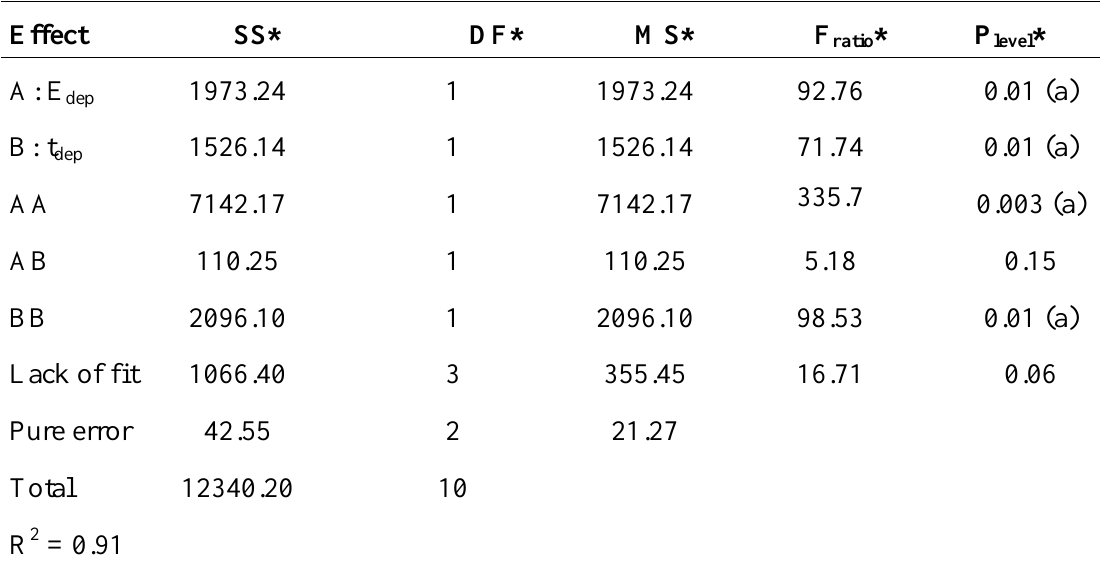
Table 2. ANOVA with the data of the 2 2 central composite design for optimization of experimental variables in Sb (III) determination by